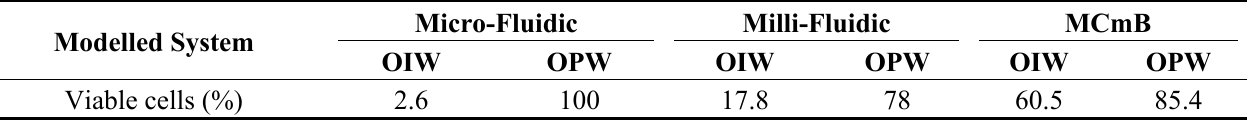
Table 5. Estimated percentage of viable encapsulated hepatocytes for each investigated configuration considering either oxygen impermeable walls (OIW) or oxygen permeable walls